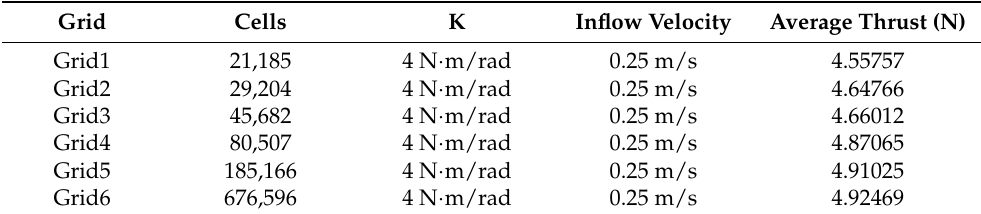
Table 4. The numerical results of the different levels of cells. Grid Cells K